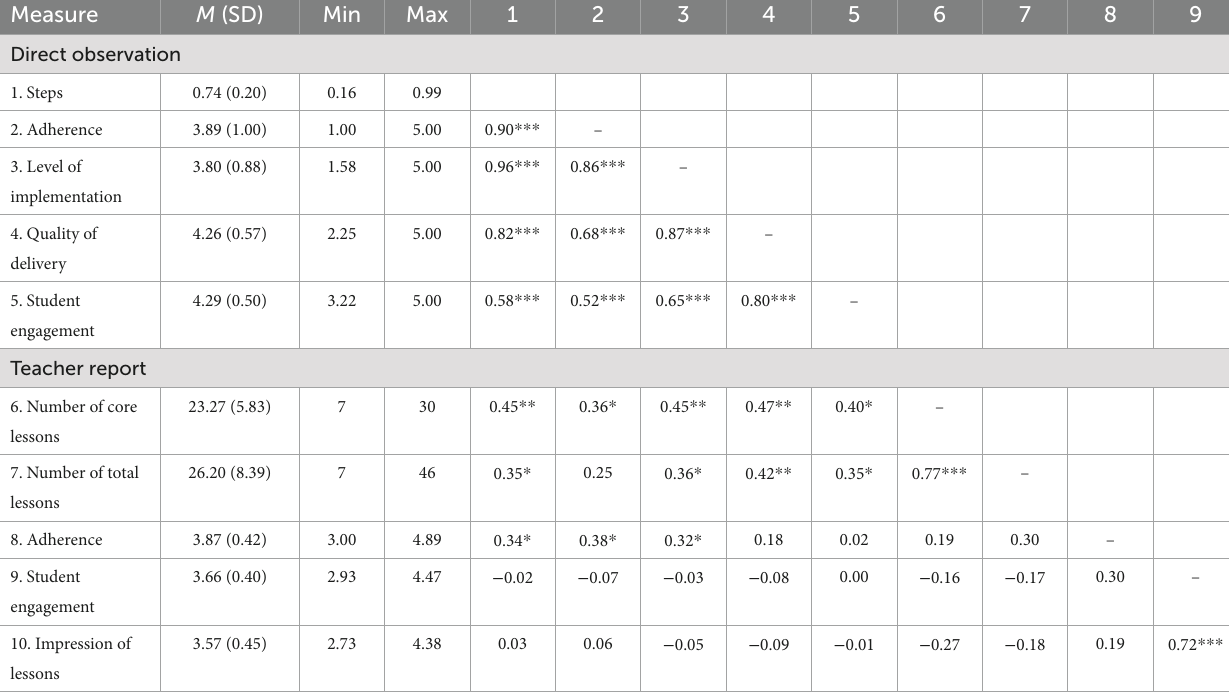
TABLE 1 Summary of descriptive statistics and intercorrelations for the implementation measures. Measure